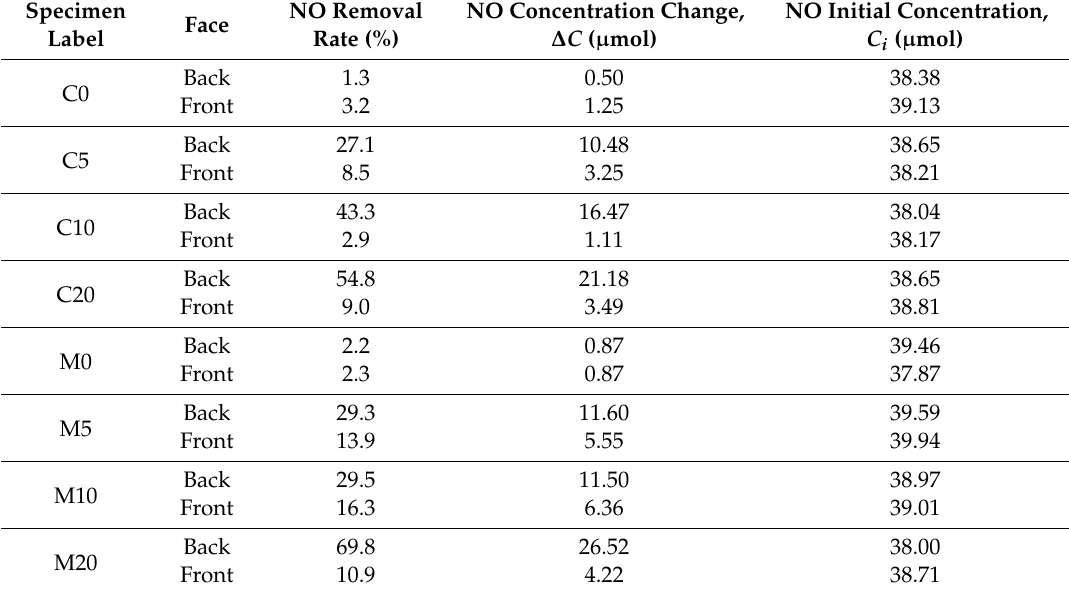
Table 3. NO removal rates by cement paste (C) and mortar (M) (unit: µ mol/(50 cm 2 · 5 h)). Specimen